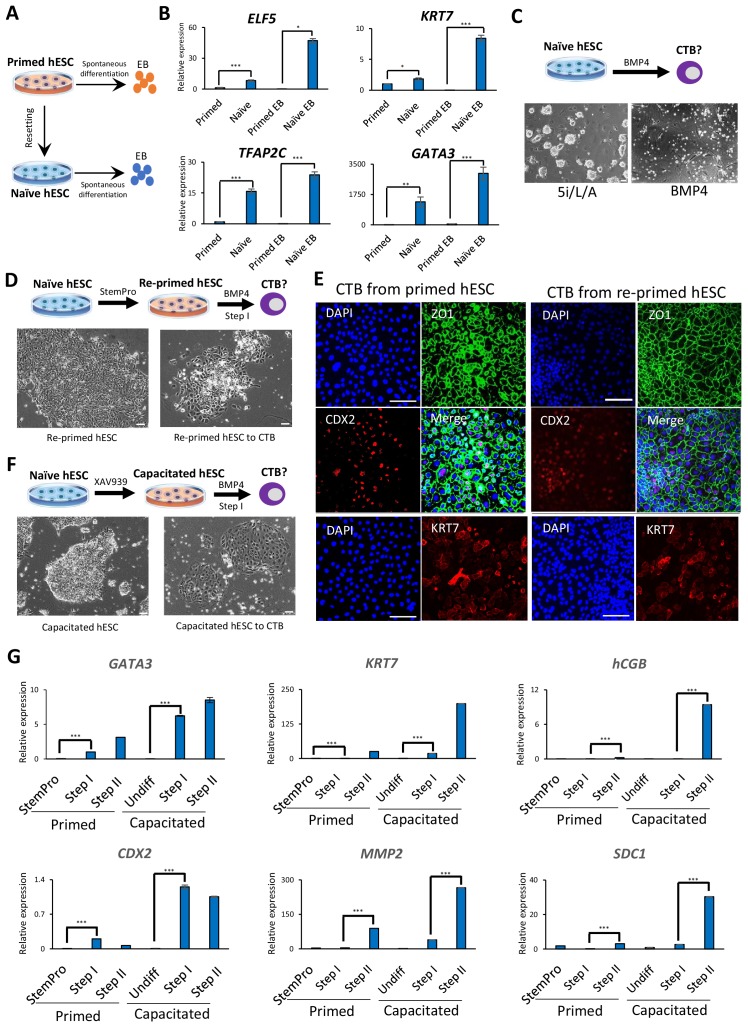
Trophoblast potential of different hPSC states under spontaneous and BMP4-mediated differentiation conditions.(A) The experimental scheme for assessing spontaneous trophoblast differentiation potential of primed and naïve hPSCs by using EB formation assay. (B) Quantitative gene expression analysis for trophoblast marker genes ELF5, KRT7, TFAP2C, and GATA3 in H9 primed and naïve hPSCs and EBs generated from the respective hPSCs. Error bars indicate ±1 SD of technical replicates. ‘*' indicates a p-value<0.05, ‘**' indicates a p-value<0.01, and ‘***' indicates a p-value<0.001. (C) The experimental scheme for assessing BMP4-mediated trophoblast differentiation potential of naive hESCs (top). Phase contrast image of H9 naïve hESCs and H9 naïve hESCs following the 6 day step I protocol for BMP4-mediated CTB differentiation (bottom). The scale bars indicate 75 μm. (D) The experimental scheme of re-priming naïve hESCs and assessing their BMP4-mediated trophoblast differentiation potential (top). Phase contrast images of H9 re-primed hESCs and H9 re-primed hESCs following the 6 day step I protocol for BMP4-mediated CTB differentiation (bottom). The scale bars indicate 75 μm. (E) Immunofluorescence staining for CDX2, ZO1, and KRT7 in CTBs generated from H9 primed and re-primed hESCs. The scale bars indicate 75 μm. (F) The experimental scheme of capacitating naïve hESCs and assessing their BMP4-mediated trophoblast differentiation potential (top). Phase contrast images of H9 capacitated hESCs and H9 capacitated hESCs following the 6 day step I protocol for BMP4-mediated CTB differentiation (bottom). The scale bars indicate 75 μm. (G) Quantitative gene expression analysis for trophoblast marker genes GATA3, CDX2, KRT7, MMP2, hCGB, and SDC1 in H9 primed and capacitated hESCs and trophoblasts differentiated from the respective hPSCs. Error bars indicate ± 1 SD of technical replicates. ‘***' indicates a p-value<0.001.